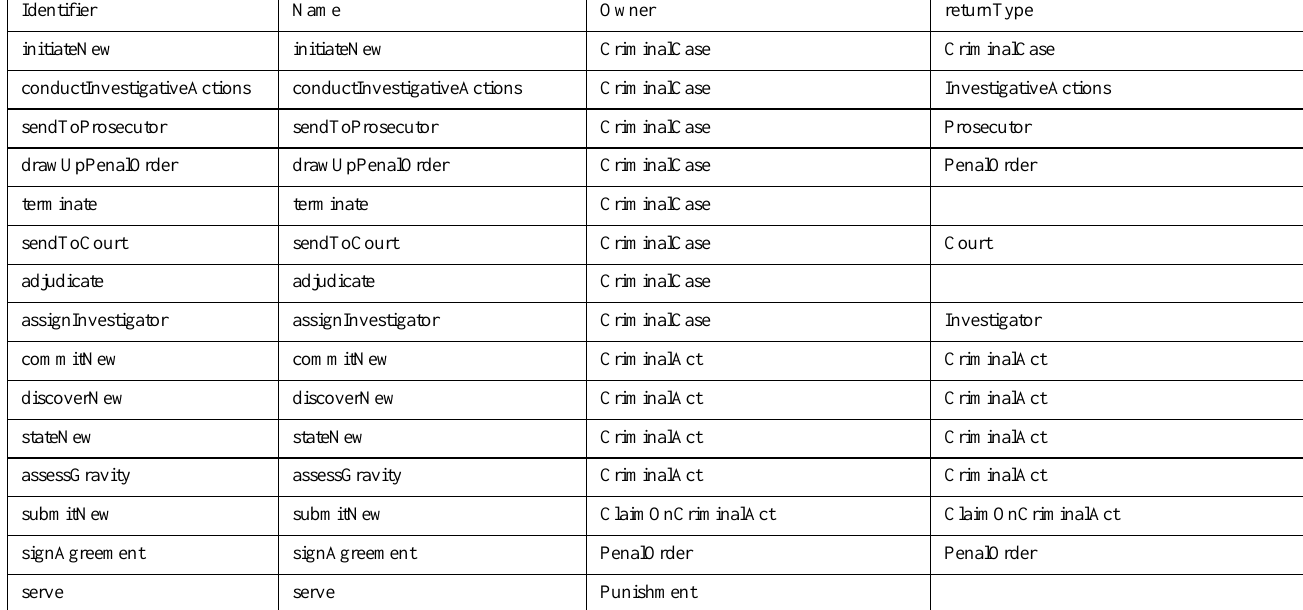
F RAME I NSTANCES FOR T OPOLOGICAL O